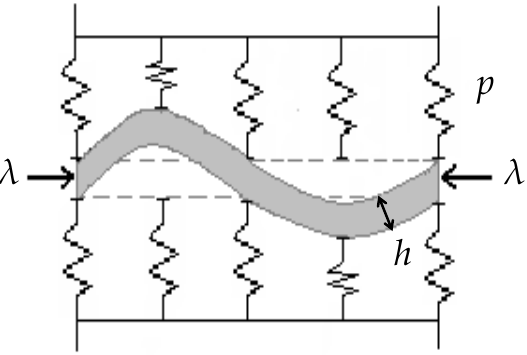
Figure 3. The cross section of the deformed plate with the thickness h after buckling loads λ , restrained by unilateral contact with the elastic foundation of Winkler’s spring type with the intensity p . The plate comes in contact with the upper or lower foundations (obstacles) if w > 0 or w < 0, respectively (see Figure 3).